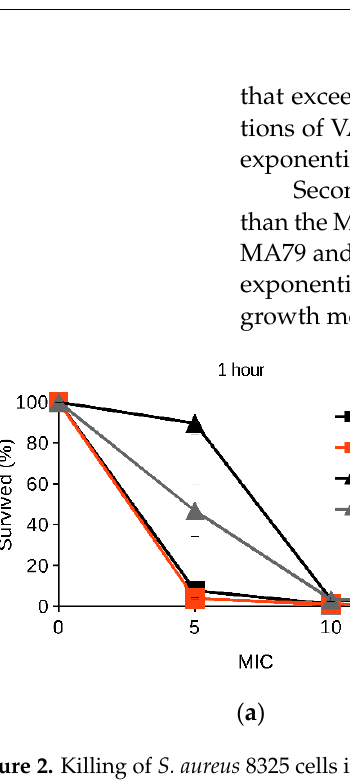
( a ) ( b ) Figure 4. Killing of cells of different S. aureus strains during one hour of treatment by antibiotics vancomycin (VAN), teicoplanin (TEI), MA79, and ERJ390 pre-grown to exponential ( a ) or stationary ( b ) growth phases. The antibiotics were used at a concentration exceeding the MIC 5-fold and 50-fold against S. aureus cells in exponential or stationary growth phases, respectively. 2.2. MA79 and ERJ390 Do Not Induce S. aureus Biofilm Formation Antibiotics at subinhibitory concentrations can induce biofilm formation in bacteria [10]. Therefore, the ability of MA79 and ERJ390 to induce biofilm formation in S. aureus strains 8325, Newman, and Mu50 was investigated. Under our experimental conditions, biofilm formation was not induced or abrogated at subinhibitory concentrations of VAN [11]. On the contrary, TEI strongly induced biofilm formation in 8325 and to a lesser ex- tent in Newman (Figure 5). Mu50 did not form biofilm under our growth conditions. MA79 and ERJ390 inhibited biofilm formation at subinhibitory concentrations. Thus, MA79 and ERJ390 did not induce S. aureus biofilm formation but prevented it at subin- hibitory concentrations.